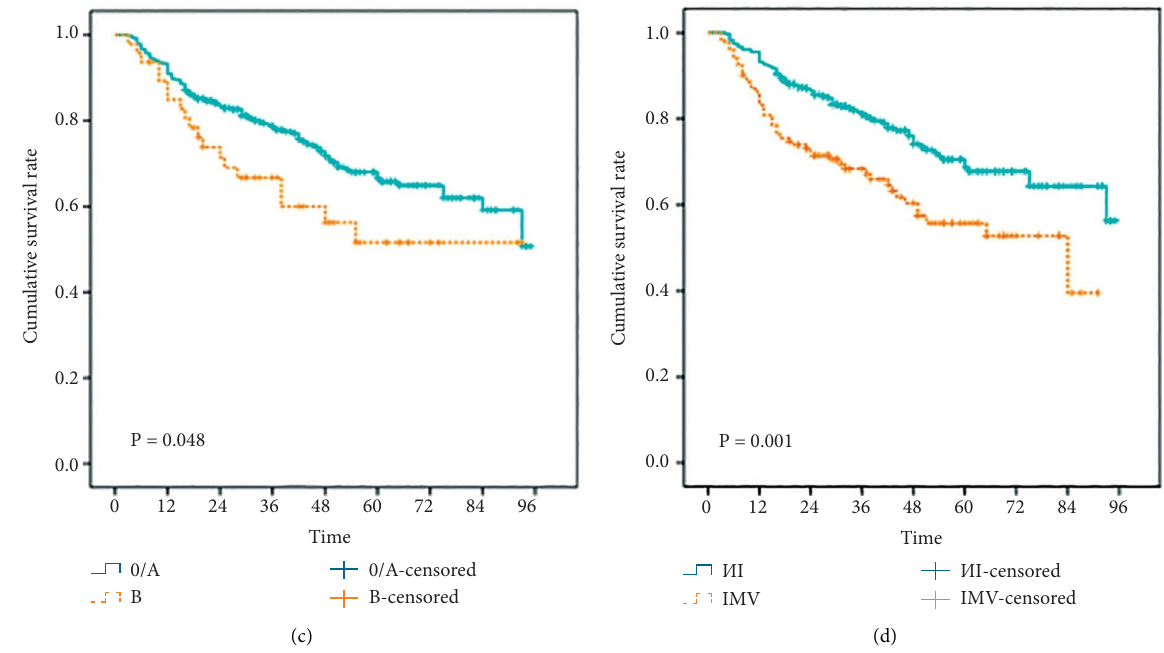
Figure 3: The overall cumulative survival rate stratified by MVI and non-MVI (a), TB ≤ 20.5 μ mol/L and TB > 20.5 μ mol/L (b), BCLC 0/A and BCLC B (c), and Edmondson I/II and III/IV non-MVI (Figure 3(a), P ≤ 0 . 001), preoperative TB level ≤ 20.5 μ mol/L and preoperative TB level > 20.5 umol/L (Figure 3(b), P � 0 . 011), BCLC 0/A and BCLC B (Figure 3(c), P � 0 . 048), and Edmondson I/II and III/IV (Figure 3(d), P � 0 . 001).